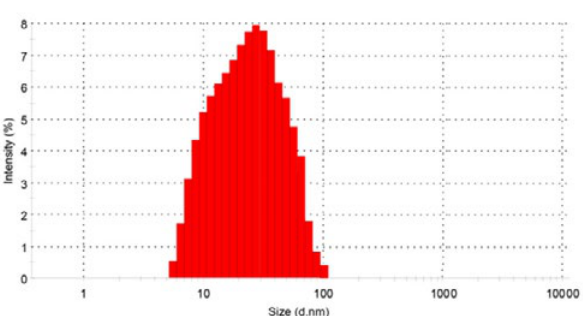
Fig. 4. TGA of nano-colloidal silica @APTPOSS Fig. 4 . TGA of nano-colloidal silica @APTPOSS